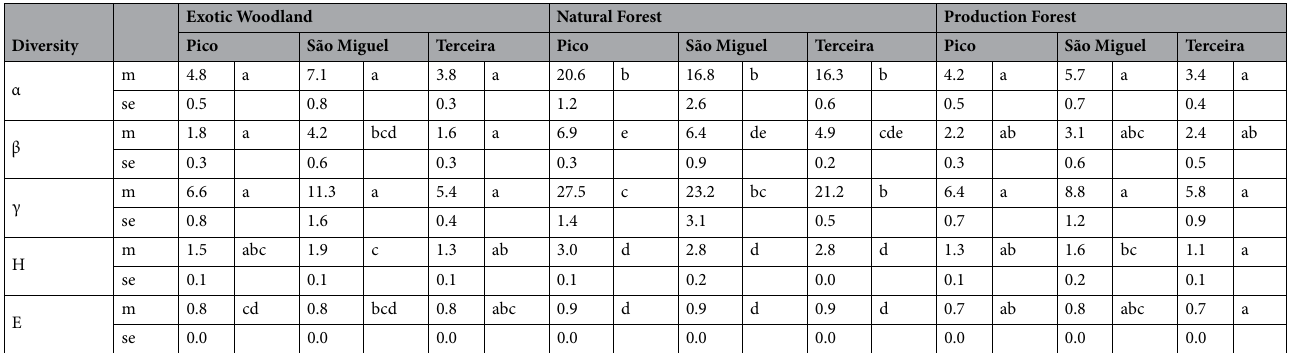
Table 2. Plant taxonomic diversity found at 90 forests in the Azores, from three islands (Pico, São Miguel, and Terceira) and three forest types (Exotic Woodland, Natural Forest, and Production Forest). Alpha, beta and gamma diversities, Shannon diversity (H) and Evenness (E). Mean and standard error for each diversity parameter. For each row, different letters indicate significant differences (p < 0.05) according to the results of a Tukey test applied after ANOVA.